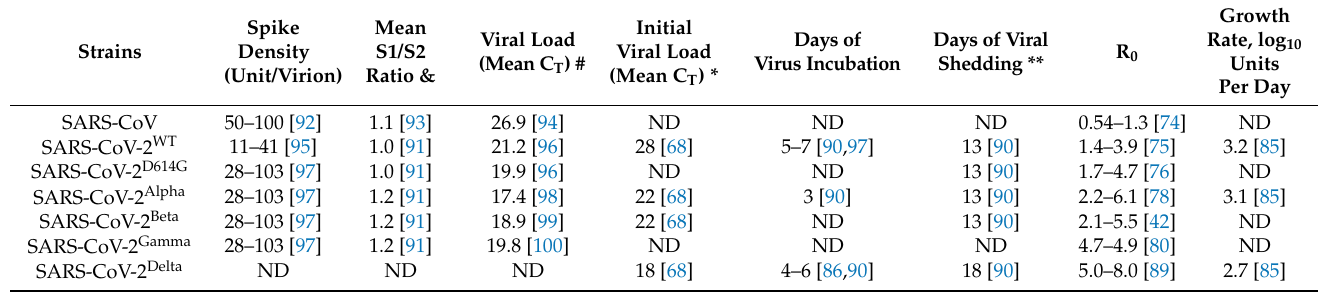
Table 2. Biological features of SARS-CoV, SARS-CoV-2, and SARS-CoV-2 variants. The